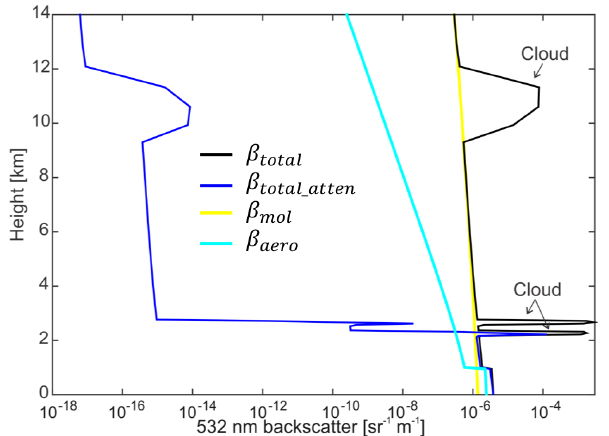
Figure 3. Lidar observables from CR-SIM for a cumulus case from LASSO using WRF with the Morrison 2-moment microphysics scheme. Example of simulated vertical profiles are shown for β total , β total_atten , β mol , and β aero at a wavelength of